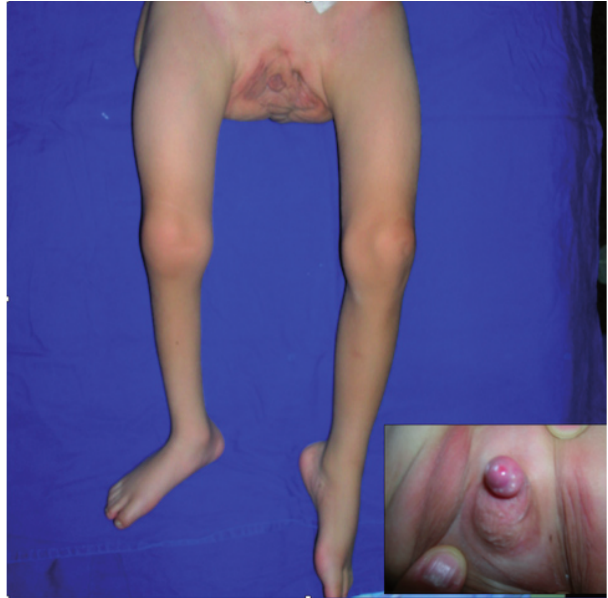
Figure 2. Posterior view showing perineal mass with central orifice in detail ( A ). Lateral view ( B ), and perspective ( C ).